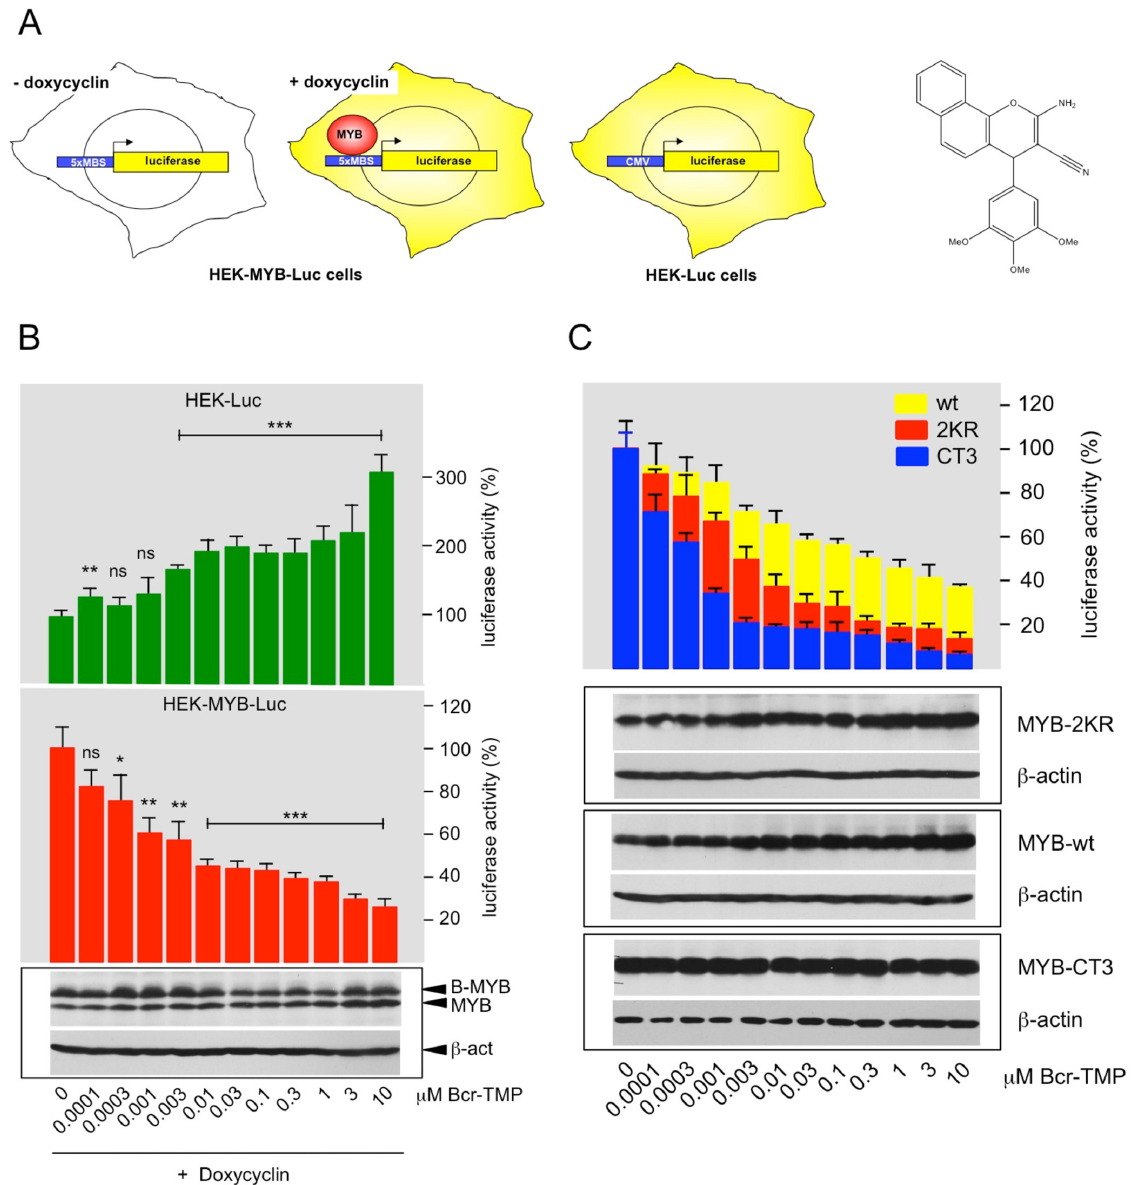
Figure 1. Identification of a highly active MYB-inhibitory compound: ( A ) HEK-MYB-Luc cells carry a MYB-inducible luciferase reporter gene and a doxycycline-inducible expression system for human MYB-2KR. HEK-Luc cells carry a constitutively active luciferase expression vector. The structure of Bcr-TMP is shown on the right. ( B ) HEK-Luc and HEK-MYB-Luc cells were treated for 16 h with doxycycline and the indicated concentrations of Bcr-TMP. Bars show the average luciferase activity of the cells normalized to the luciferase activity of cells treated only with doxycycline. The bottom panels show the expression of MYB, B-MYB (which cross-reacts with the anti-MYB antibody) and β -actin determined by Western blotting. Asterisks indicate statistical significance (ns: non-specific; * p < 0.05; ** p < 0.01; *** p < 0.001; Student’s t -test). ( C ) HEK293T cells were transiently transfected with the MYB-responsive reporter plasmid pGL4-5xMRE(GG)-Myc and expression vectors for wt MYB, MYB-2KR and MYB-CT3. Transfected cells were distributed in identical aliquots into microtiter plates and treated for 16 h with the indicated compound concentrations. Bars show the average luciferase activity of the cells normalized to untreated cells. The bottom panels show the expression of MYB, MYB-2KR, MYB-CT3, and β -actin under the different conditions. The uncropped Western blots have been shown in Figure